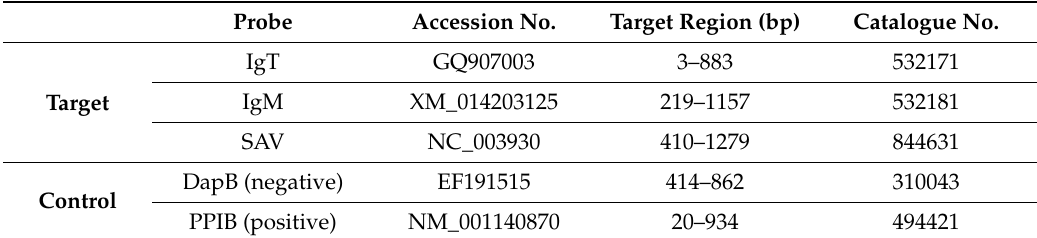
Table 1. Target and control probes for in situ hybridization.